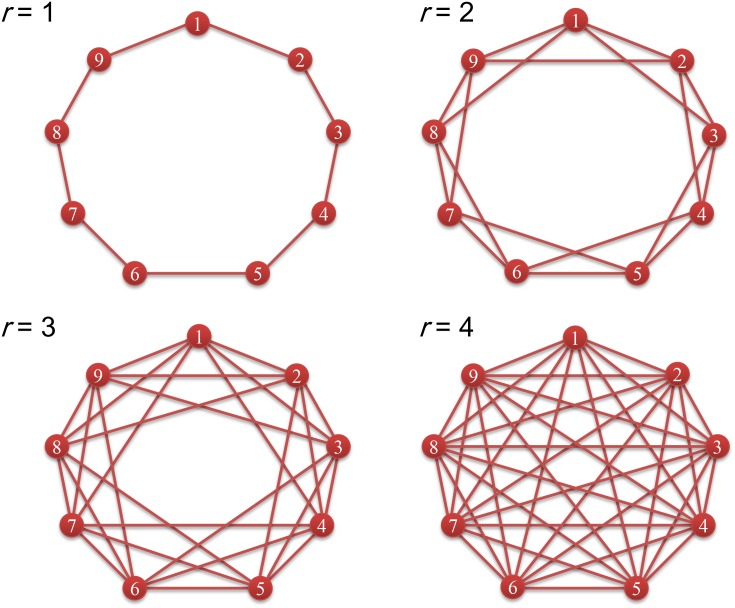
Migration patterns characterized by the migration ranger.Nine groups (red node) are arranged in a regular circle and labelled from 1 to 9 in clockwise. An edge exists between two nodes if and only if there is a potential single-step migration path between them. In other words, an offspring can migrate to one of the nodes connected to the node in which the parent is located. The distance between two groups takes on one of the values 1, 2, 3, 4. The migration range r means that the set of the displacements that a single-step migration leads to is Ω(r) = {1,⋯,r}.